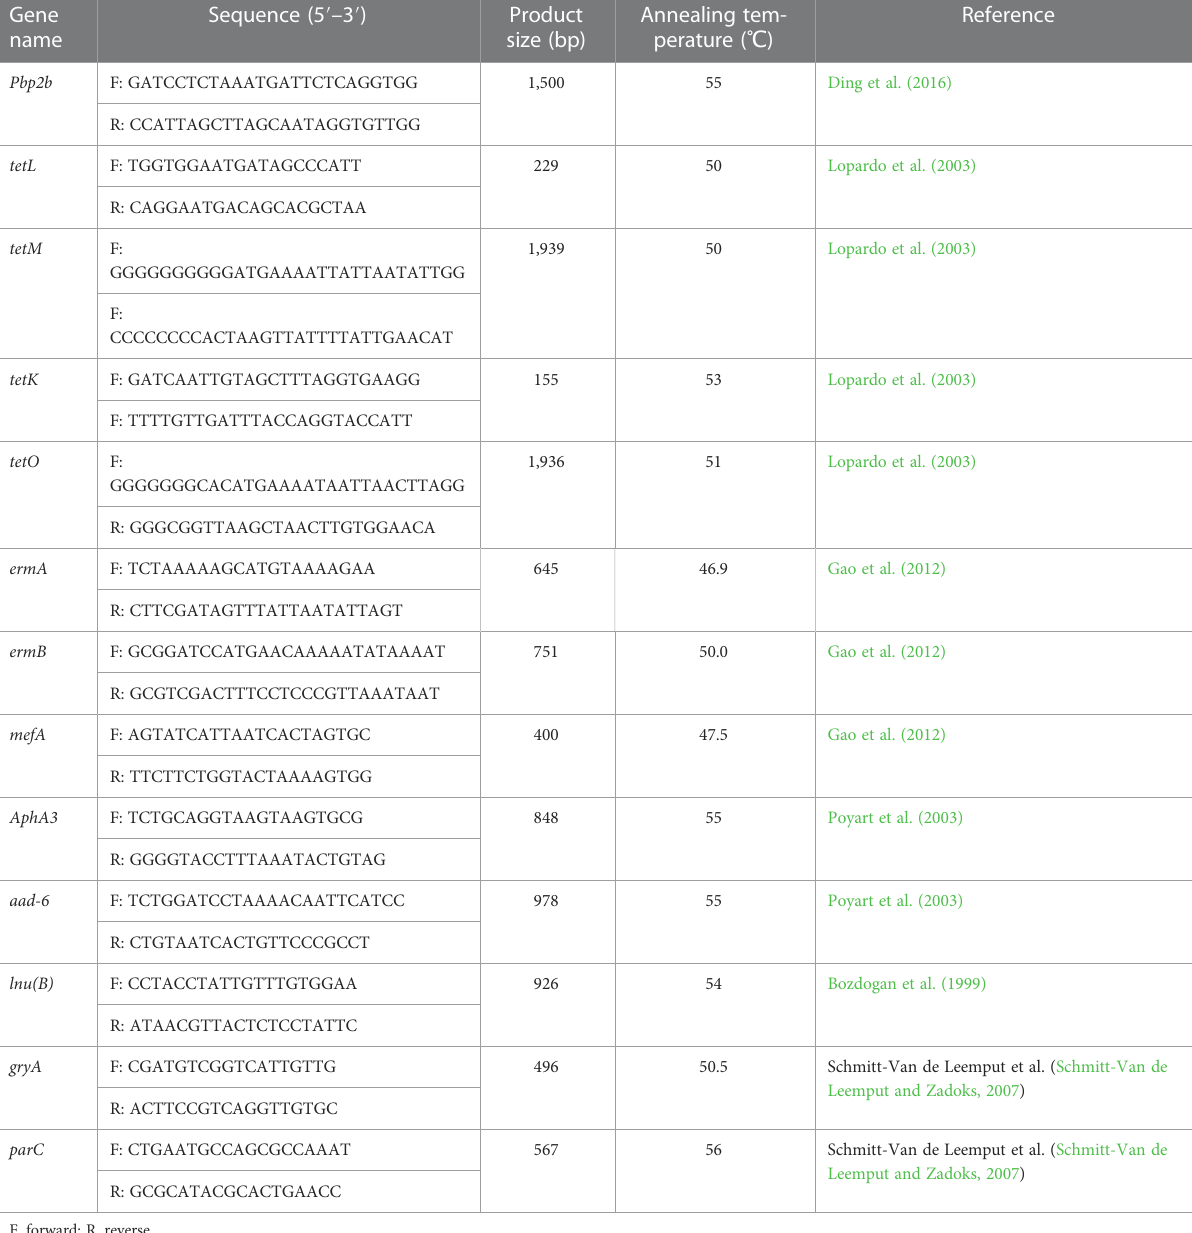
TABLE 2 Primers of resistance genes.